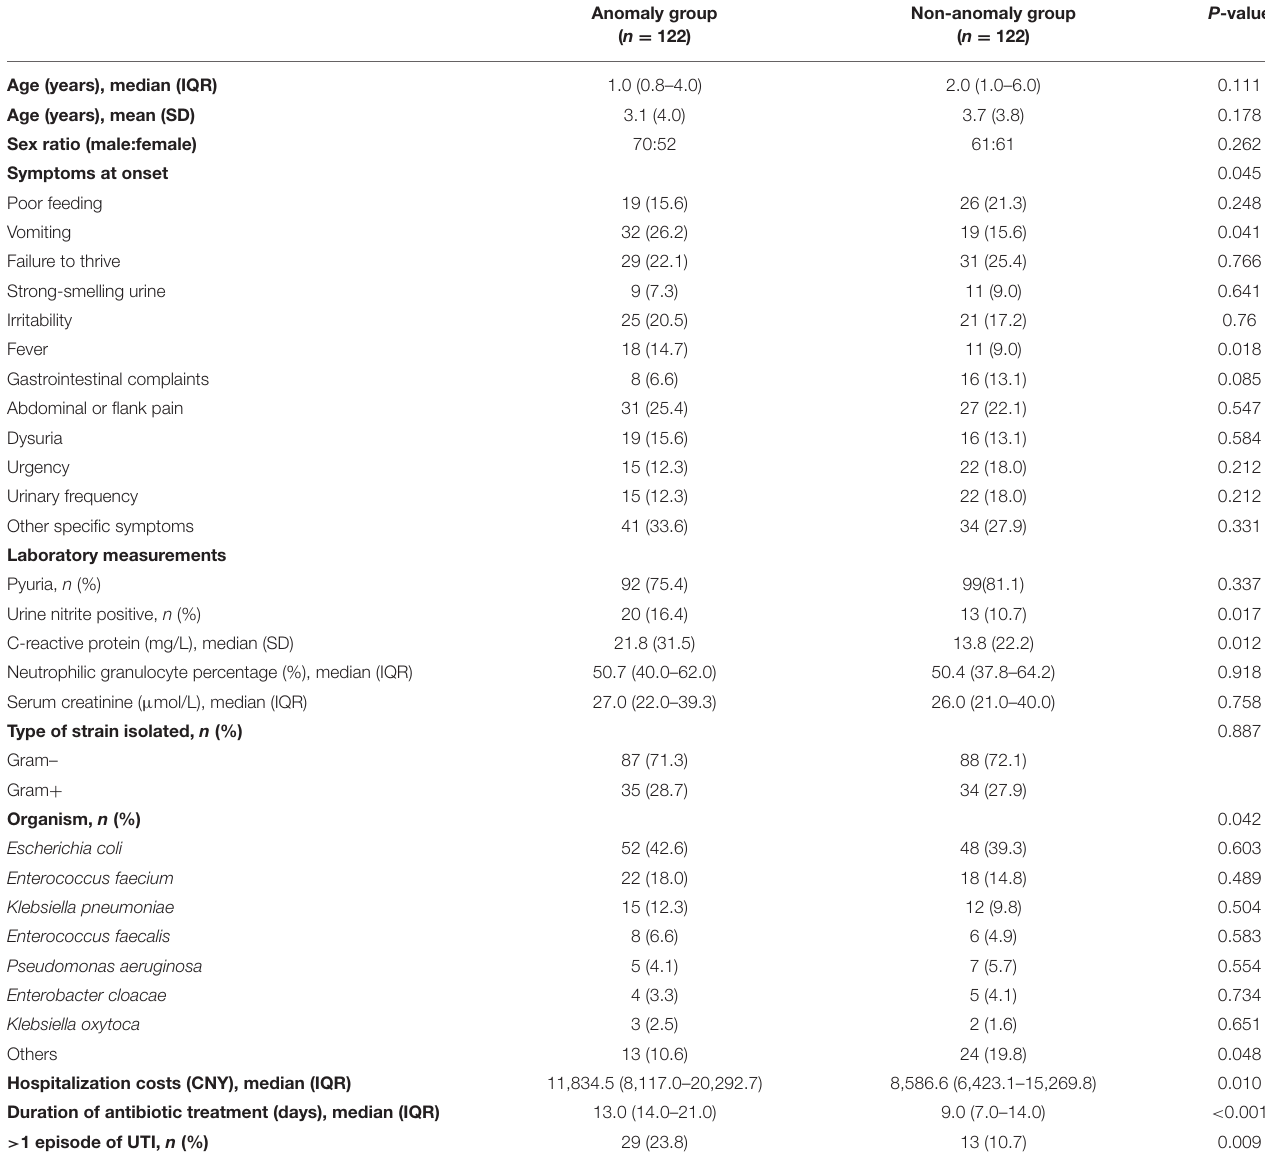
TABLE 4 | Characteristics of patients in the propensity score matched